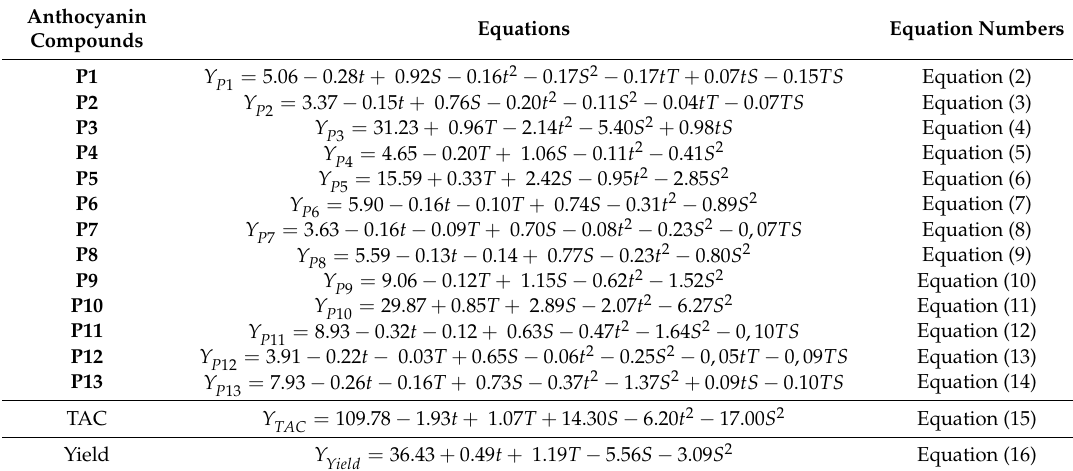
Table 4. Mathematical models produced after fitting Equation (1) to the data set (individual and grouped